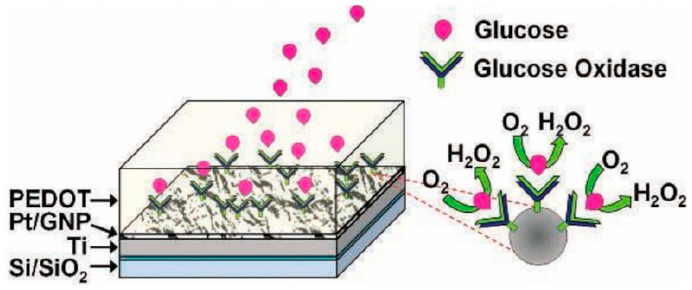
Figure 6. Schematic diagram of GO/PEDOT biofunctionalized PtNP-MGPN glucose biosensor [28].